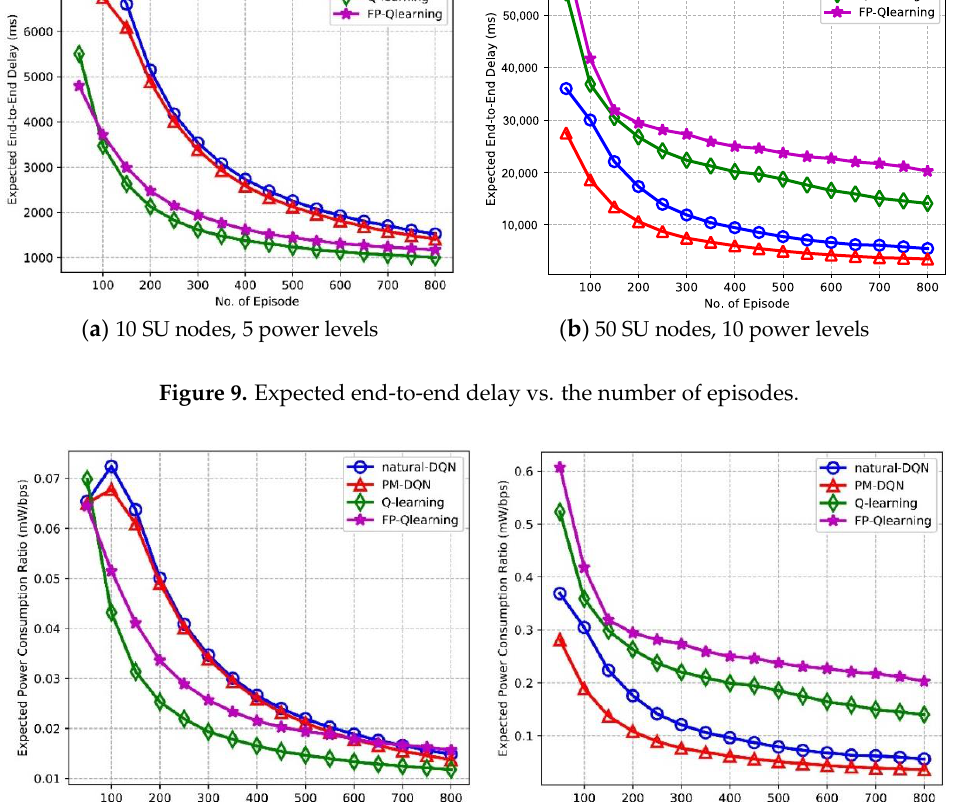
Figure 9. Expected end-to-end delay vs. the number of episodes.